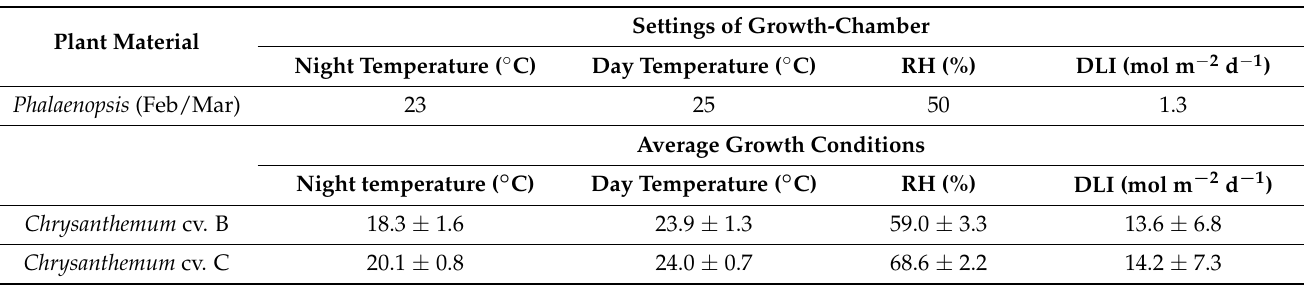
Table 1. Growth-chamber settings (day temperature, night temperature, relative humidity (RH) and daily light integral (DLI)) for in vitro plantlets Phalaenopsis (6 weeks after the last subculture for February and 4 weeks after the last subculture for March) and average growth conditions (day temperature, night temperature, relative humidity (RH) and daily light integral (DLI)) for stock